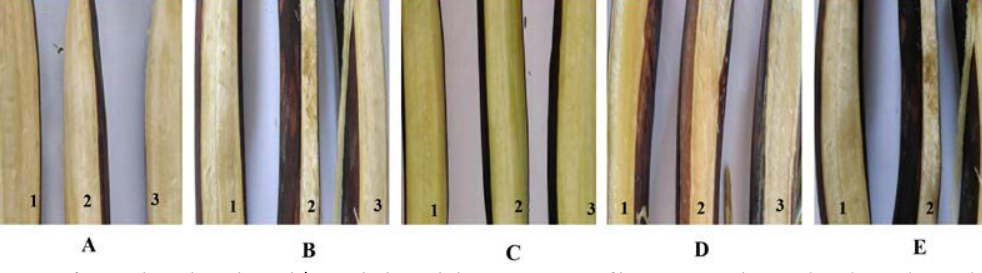
Fig. 3.7. After peeling Physiological / Morphological characterization of banana was observed and noted.A. Sodium alginate B. Starch C. Aloe vera D. Gelatin E.